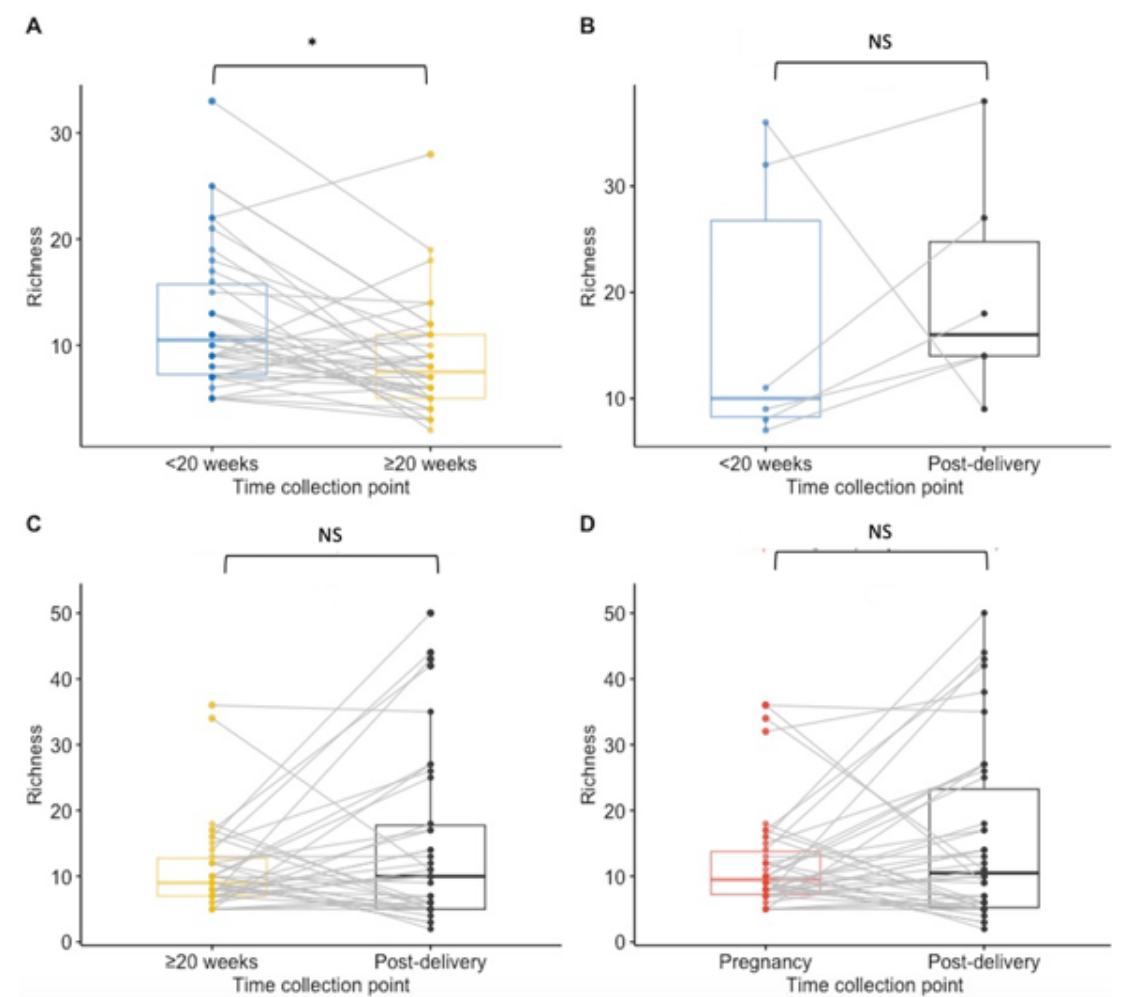
Figure 2. Boxplots for species richness at each collection point for paired samples. Results of <20 weeks GA pregnancy collection are in blue, ≥ 20 weeks GA pregnancy collection in yellow, post-delivery in black and overall during pregnancy in red. ( A ) The richness was significantly lower at the ≥ 20 weeks GA pregnancy collection point than at <20 weeks GA pregnancy collection ( p = 0.02) in matched samples from 38 women. ( B ) There was no significant difference in the richness between <20 weeks GA pregnancy collection and post-delivery matched samples from 6 women. ( C ) No significant difference was calculated in the richness between ≥ 20 weeks GA pregnancy collection and post-delivery matched samples from 38 women. ( D ) For 42 women that had samples collected at least once during pregnancy and post-delivery, no significant difference in the species richness was calculated. NS = non significant. * p -value <